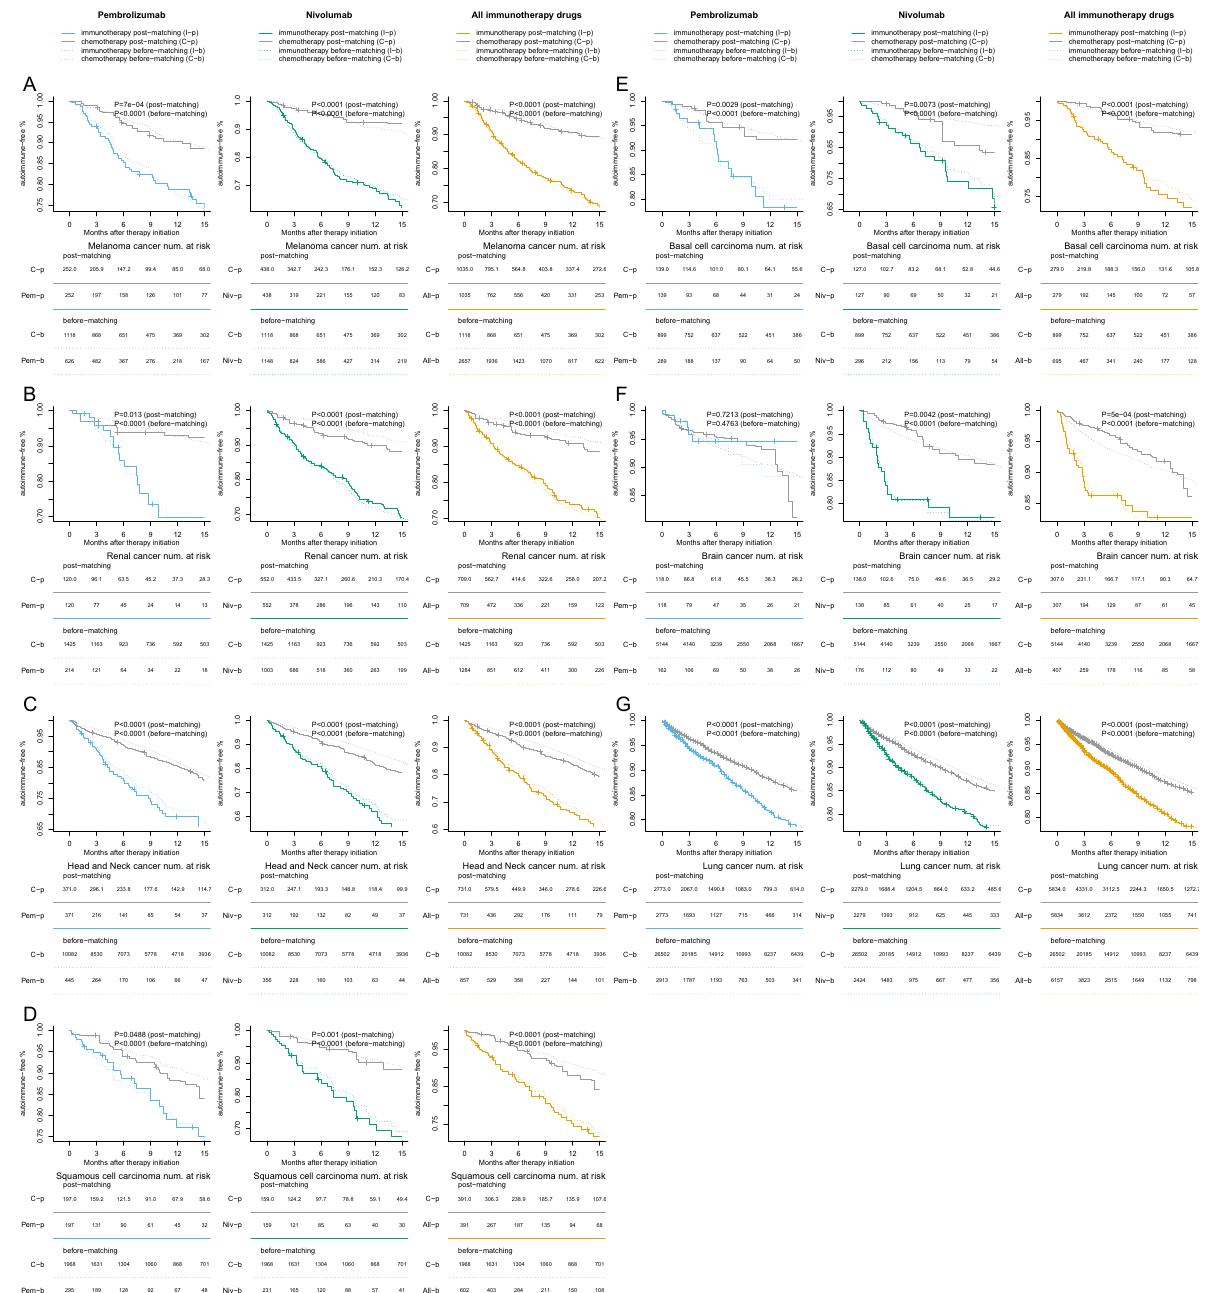
Fig. 3 Time-to-event plot showing the time between treatment initiation and the development of irAEs in seven cancer types. A Melanoma. B Renal cancer. C Head and neck cancer. D Squamous cell carcinoma. E Basal cell carcinoma. F Brain cancer. G Lung cancer. The comparisons between chemotherapy with pembrolizumab, nivolumab, and all immune checkpoint inhibitors combined are shown in the three columns respectively. The top panel is the time-to-event plot for all irAEs, with a log-rank test p -value reported on the top right corner for both matched and unmatched samples. Each tick represents 50 censored patients. The curves are truncated in the 15th month after treatment initiation for better